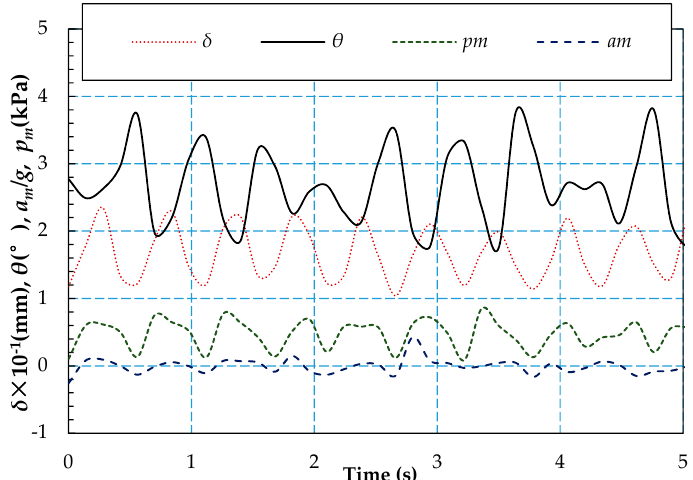
Figure 9. The monitored history of heave and pitch motion, acceleration, and pressure value measured in midship.